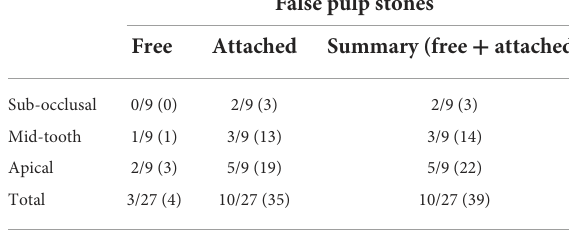
TABLE 1 Presence of false pulp stones, both free and attached, on a section level (subocclusal, mid-tooth, apical) in nine alpaca cheek